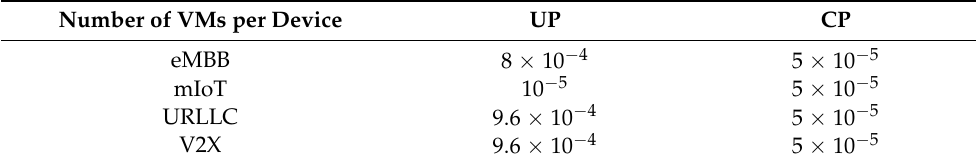
Table 4. Input VM requirements for UP and CP VNFs, per device and for different slice types. Number of VMs per Device